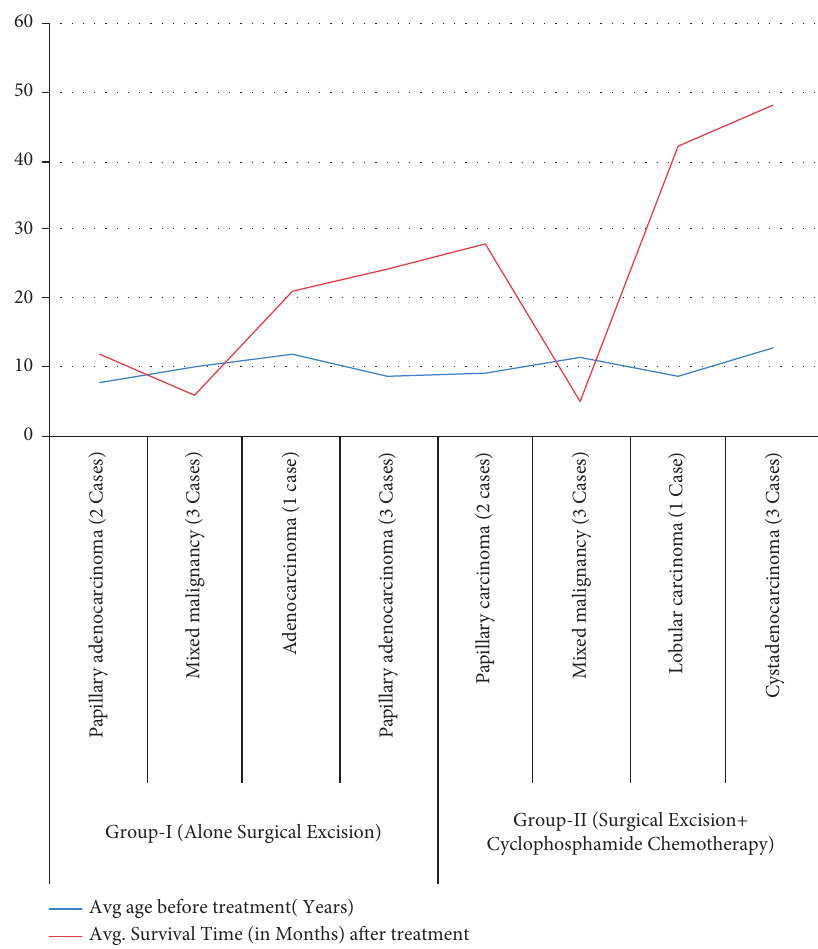
Figure 7: Line bar showing average survival time in group I and group II in the present clinical study.